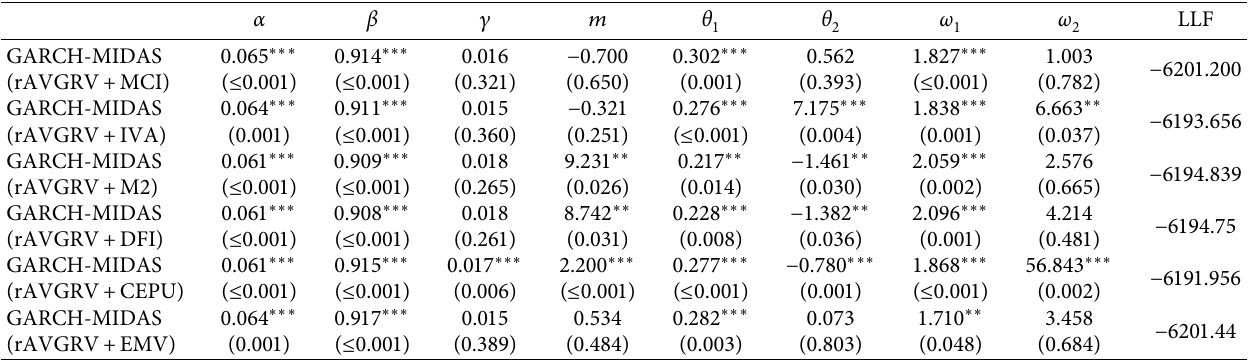
Table 8: Estimation results of multifactor GARCH-MIDAS model based on CSI 300 ( K � 12).